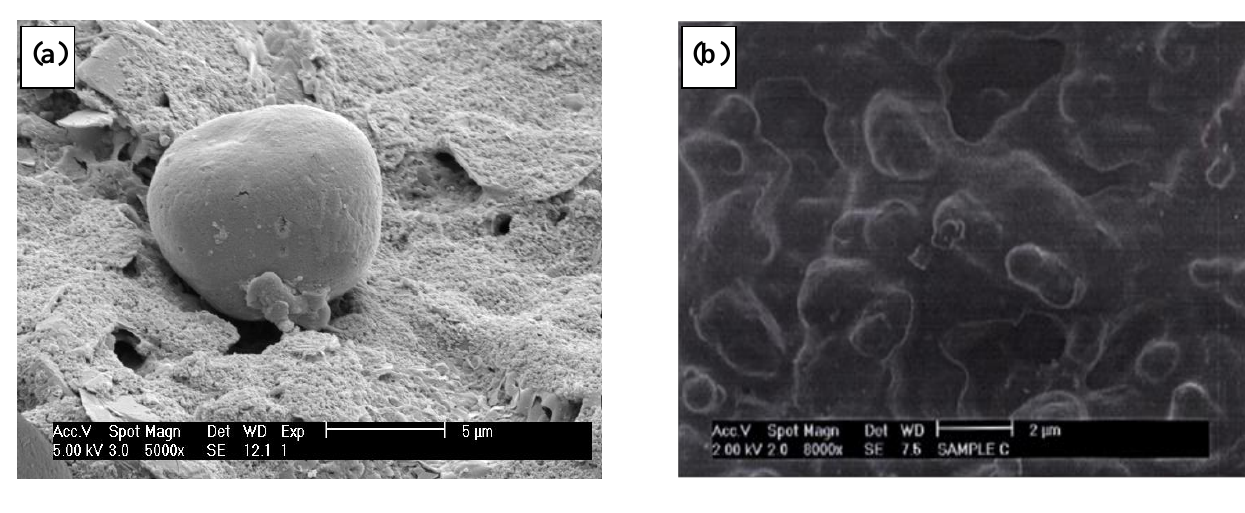
Figure 17. SEM of poly(aniline) enzyme containing polymer protrusion microelectrode arrays (a) before and (b) following coating with